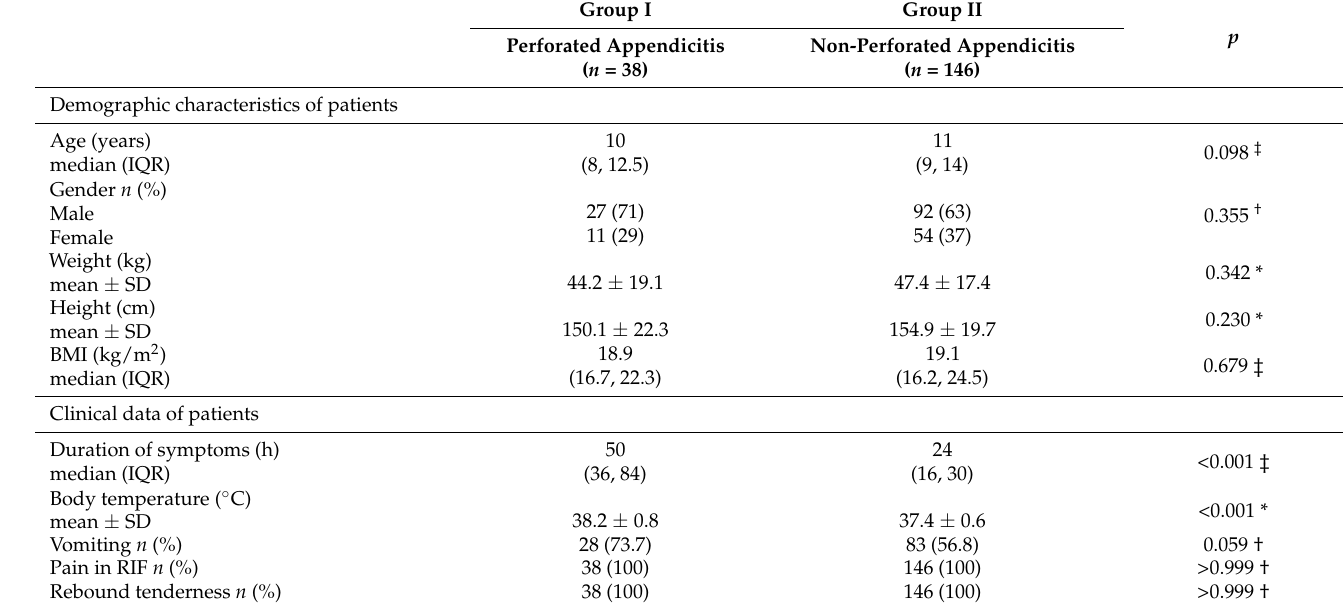
Table 2. Demographic characteristics, clinical and laboratory data of